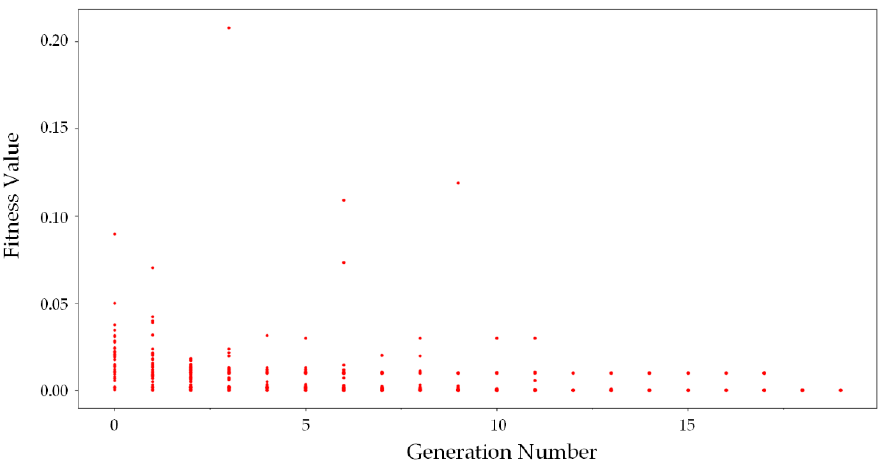
Figure 10. Neural architecture searching process of glance network. The red points represent the networks constructed by the algorithm. Table 4. Comparison results for di ff erent glance network